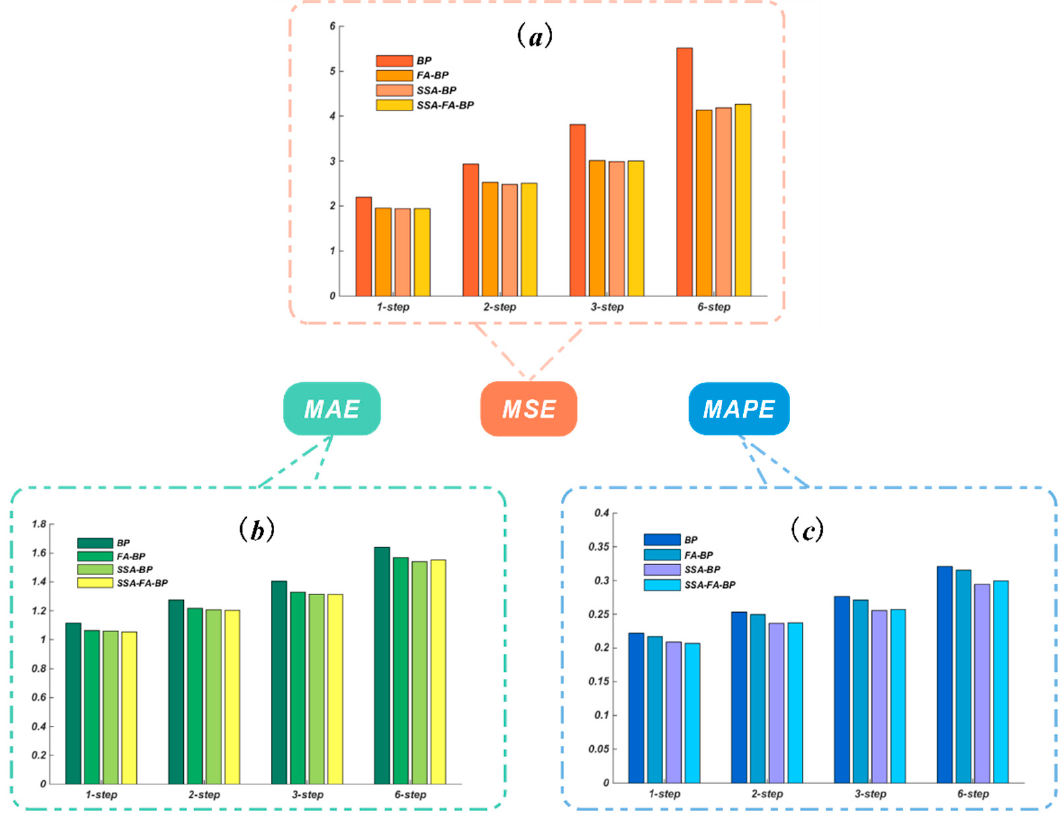
Figure 10. The multiple-steps forecasting accuracy indexes of Unit 12 (60 min), ( a ) refers to the result of MSE; ( b ) refers to the result of MAE; ( c ) refers to the result of MAPE).